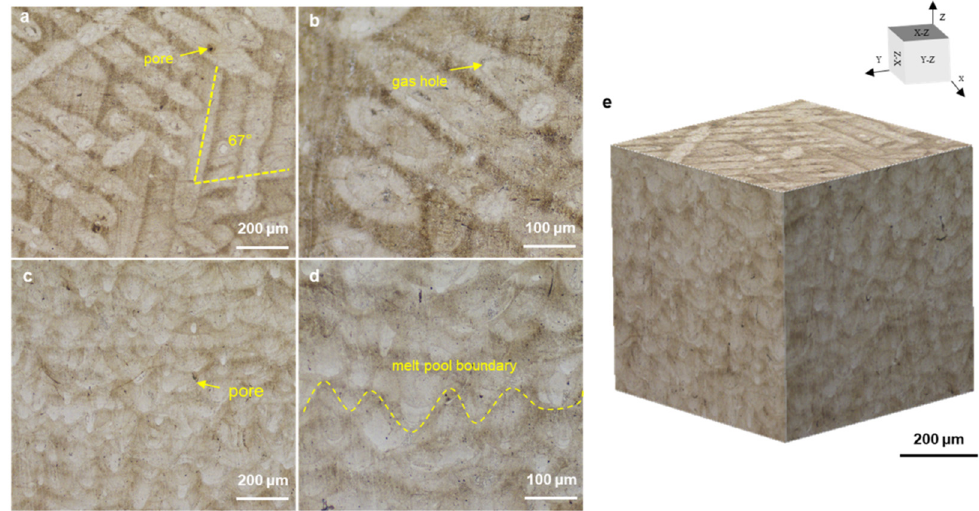
Materials 2022 , 15 , x FOR PEER REVIEW Figure 8. XRD spectra of H13 powder and as-SLMed H13 specimens at the VED of 95.8 J/mm 3 .